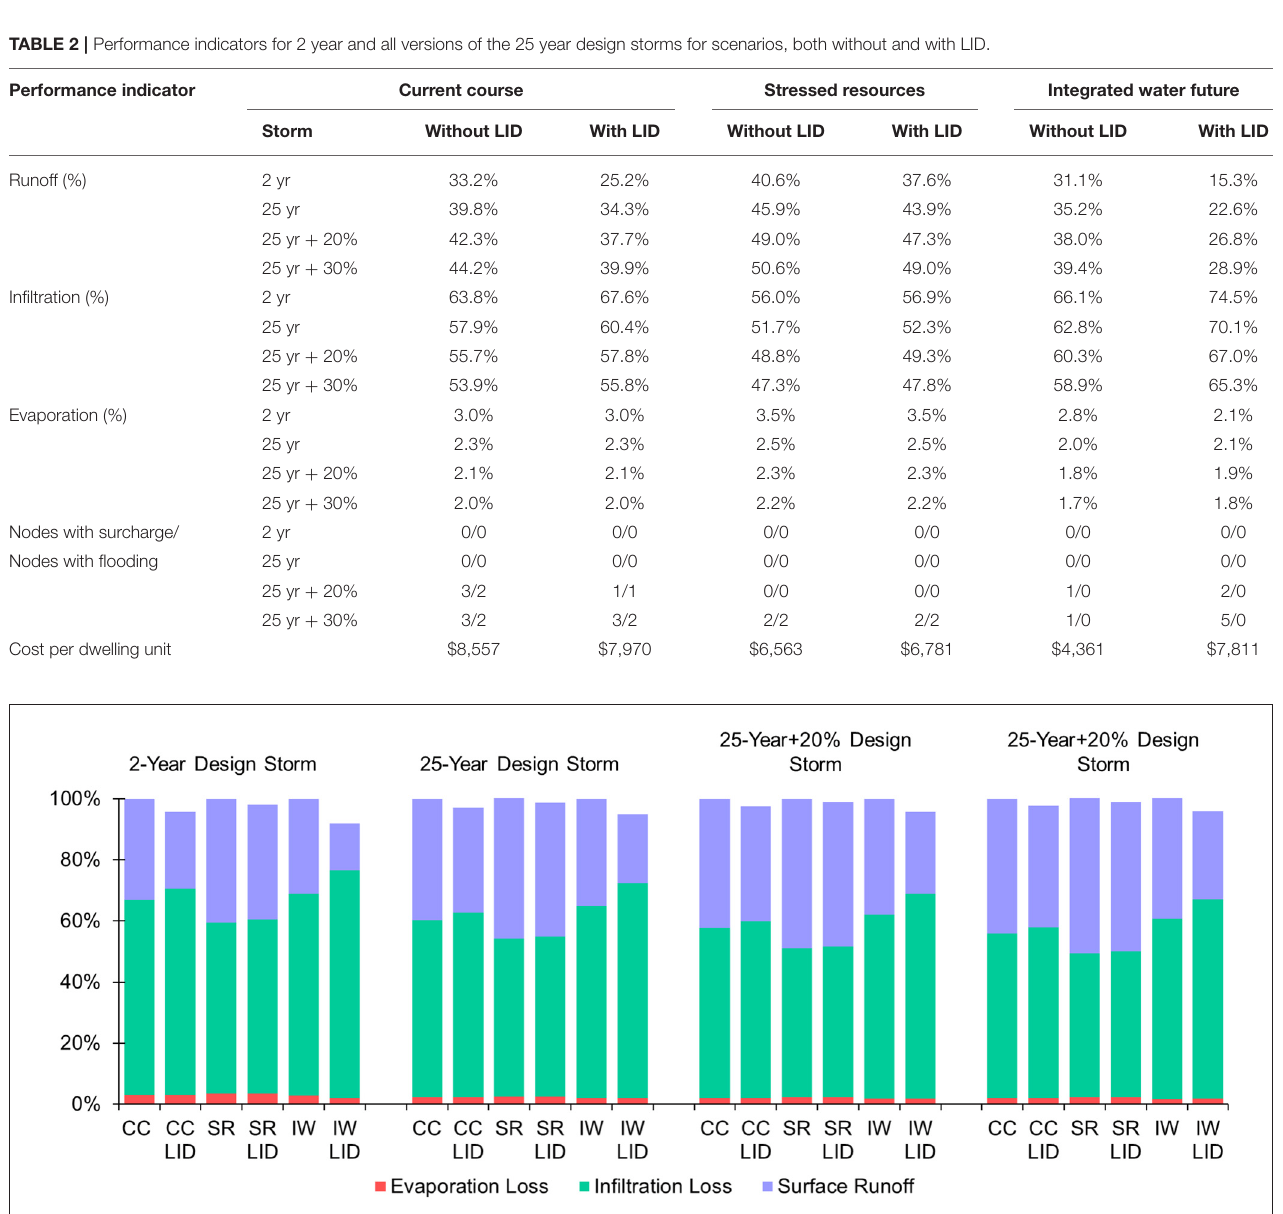
to lower peak flows ( Figure 3 ) relative to the same scenario with stormwater managed using detention ponds